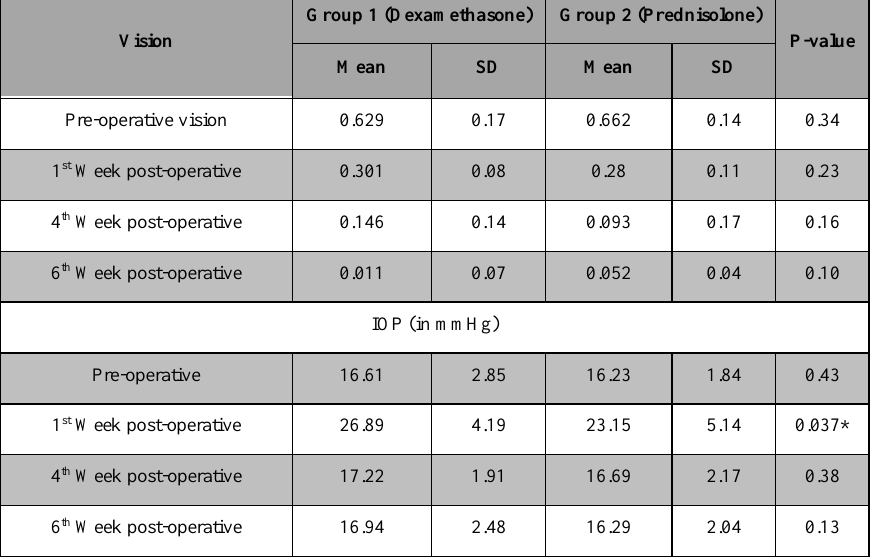
Table 1. Vision and intraocular pressure among the study